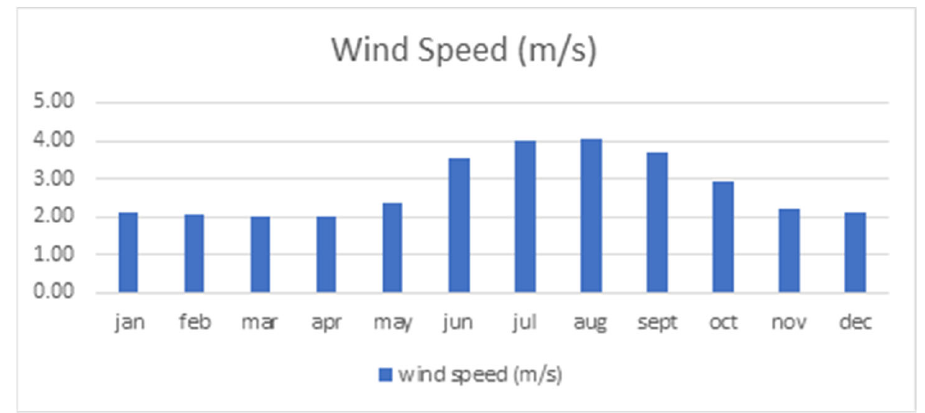
Figure 2. Wind speed at an altitude of 10 m.